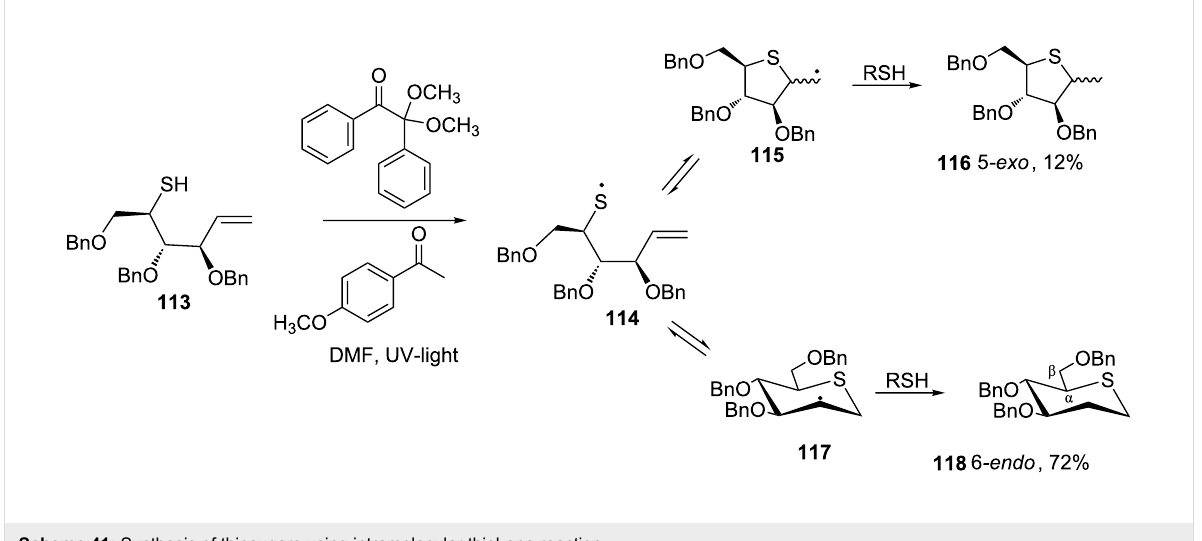
Scheme 41: Synthesis of thiosugars using intramolecular thiol-ene